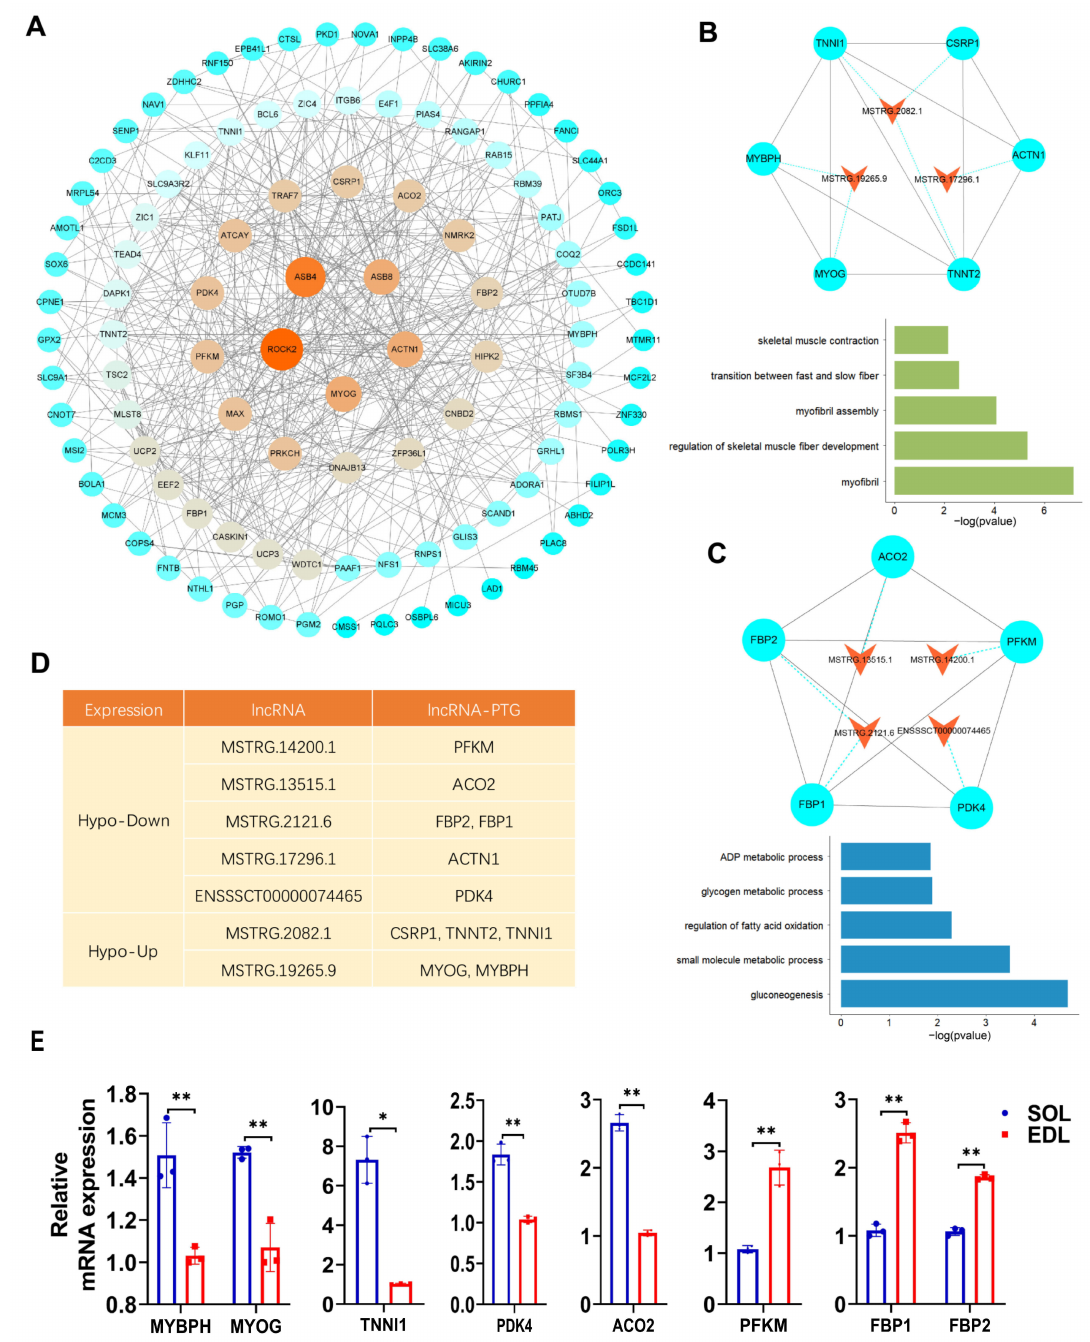
Figure 7. QTL analysis and functional enrichment of dme-lncRNAs. ( A ) Protein–protein interaction (PPI) network of PTGs of lncRNAs visualized by using Cytoscape. The size and color of circles represented the degree of interaction between the genes. ( B , C ) Above: the top two clusters from PPI network identified by using MCODE. Bottom: GO enrichment analysis of PTGs in corresponding cluster. The orange triangle node represented lncRNAs, the blue cycle node represented PTGs. Each pair of PTGs and lncRNAs was indicated by blue dotted line. The interaction of PTGs was indicated by black solid line. ( D ) The information of lncRNAs and their adjacent mRNAs from ( E ). ( E ) qPCR result showing the adjacent mRNA expressions in SOL and EDL. The relative mRNA expression was standardized to that of the control gene β -actin. Data represent mean ± SD of three independent biological replicates. * p < 0.05; ** p <